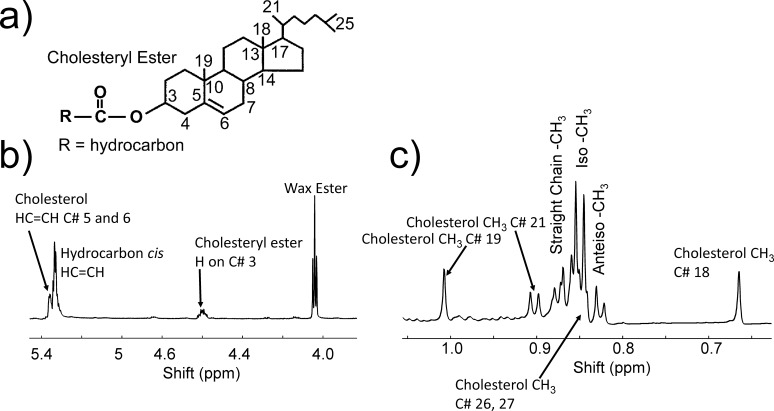
(a) Numbering used in (b) and (c) associated with CEs. (b, c) A typical NMR spectrum of meibum from a 31-year-old male Caucasian donor. The resonance due to WEs near 4.0 ppm is a triplet. The resonance due to cholesterol number C21 is a doublet. Resonances for straight chain CH3 and anteiso-CH3 moieties are composed of two major resonances, and the iso-CH3 moieties are composed of two major and one minor (left shoulder) resonance. The resonances due to cholesterol numbers C26 and 27 are not resolved but rather are buried under the straight chain resonances.